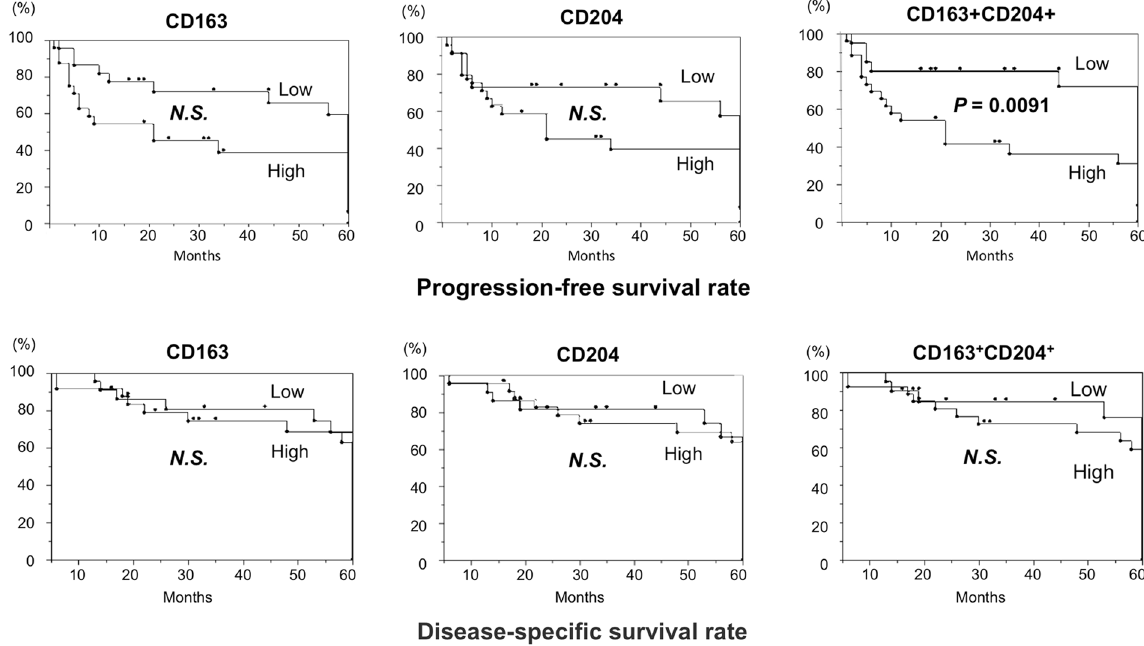
Figure 6. Survival curves according to the expression of TAM subsets in OSCC. The survival rates were calculated by the Kaplan-Meier method with high versus low expression of CD163 + , CD204 + , or CD163 + CD204 + TAMs. The classifications are described in the Materials and Methods section. Statistically significant differences between groups were determined by log-rank